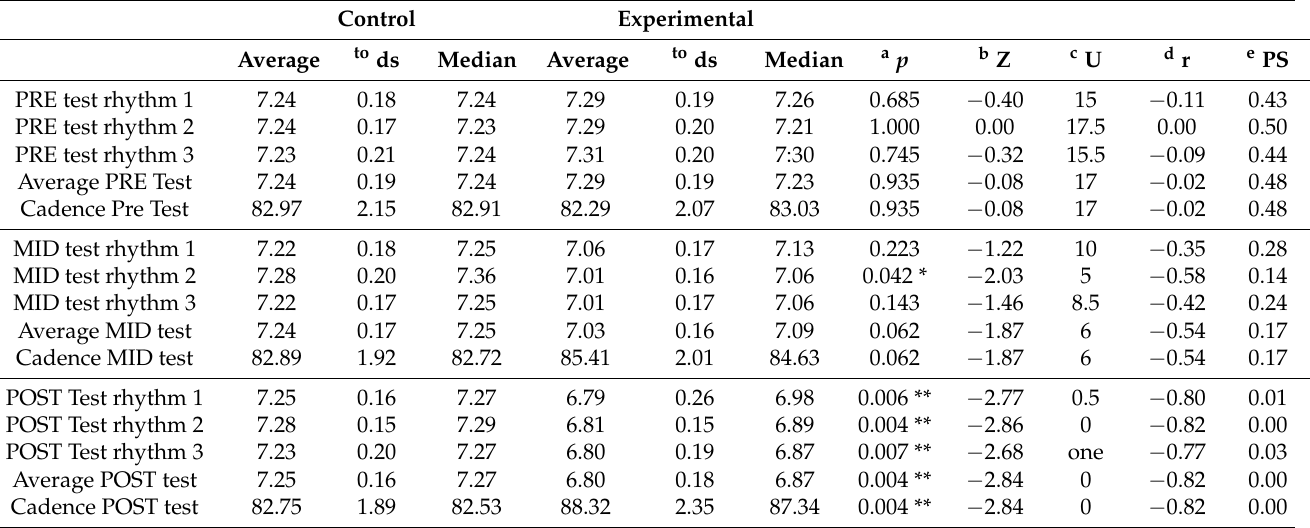
Table 4. Distribution of the tests according to the